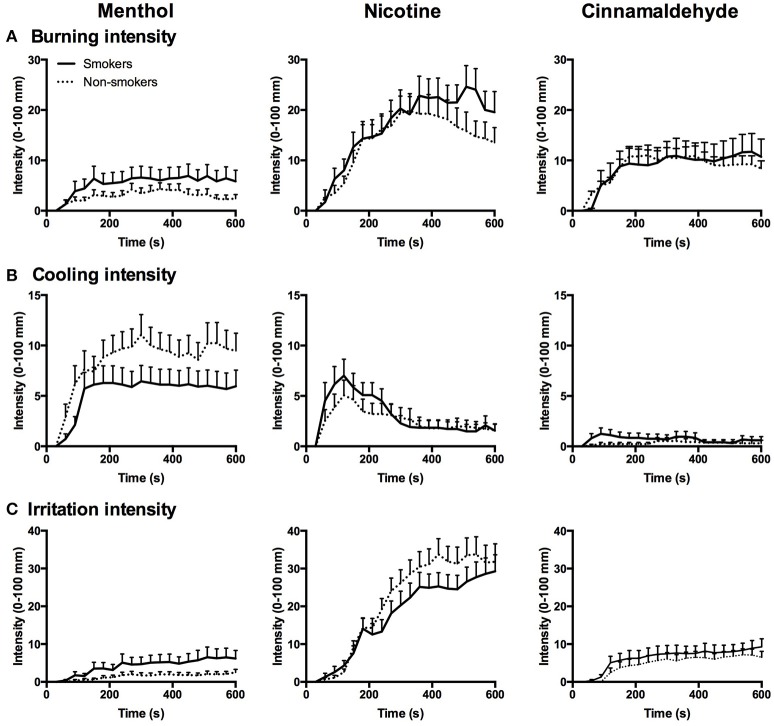
Burning (A), cooling (B), and irritation (C) intensity in response to menthol, nicotine, and cinnamaldehyde for smokers and non-smokers, data presented as mean ± SEM for every 30 s interval over the 10 min chewing regime.